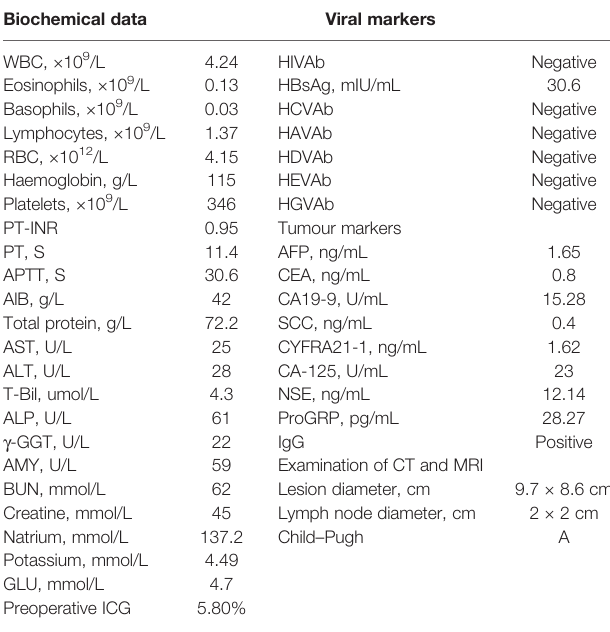
TABLE 1 | Laboratory and Imaging examination data on